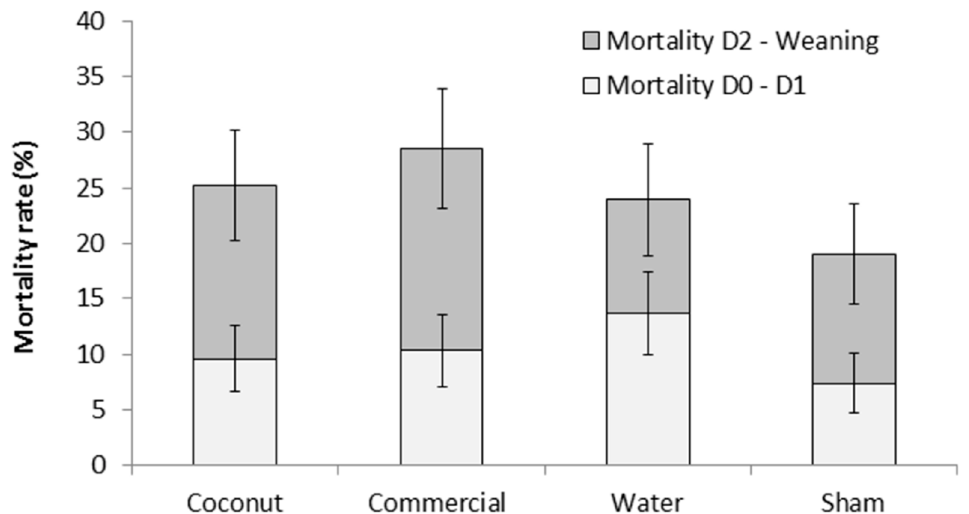
Figure 1. Mortality rates (%) of piglets during the first 24 h postpartum (D0–D1) and until weaning (D2–Weaning). Piglets were either given a 2 mL oral supplementation at 3 h postpartum (coconut oil, commercial product or water) or were sham-dosed. Preweaning mortality rate is the addition of light and dark grey bars. No significant difference was detected.